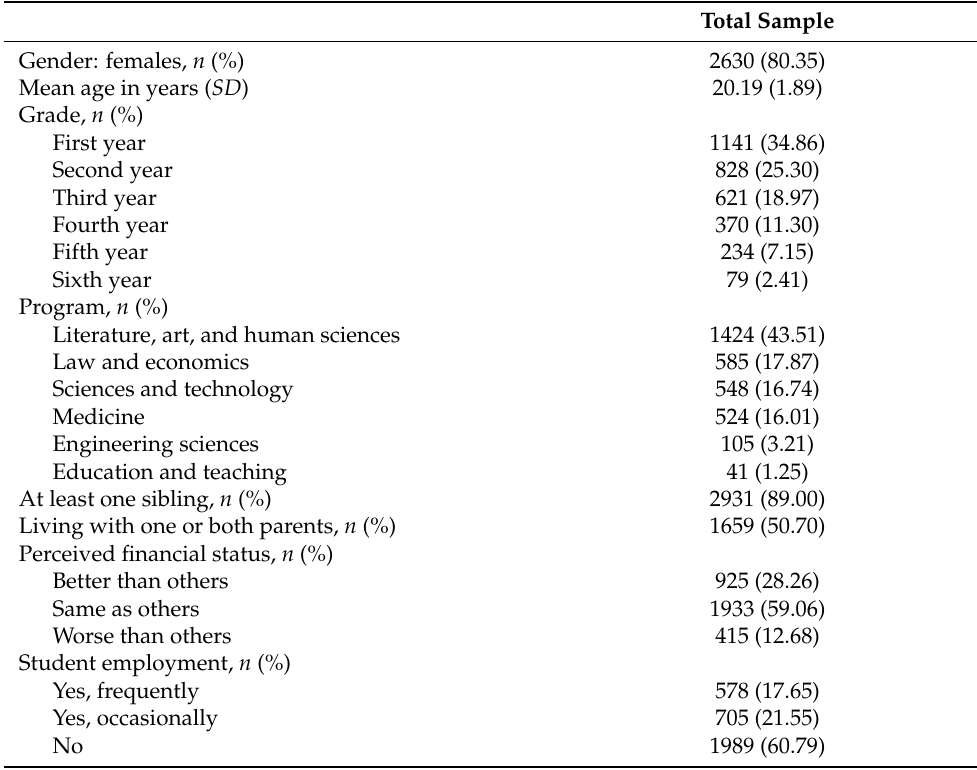
Table 1. Sample sociodemographic characteristics ( N =